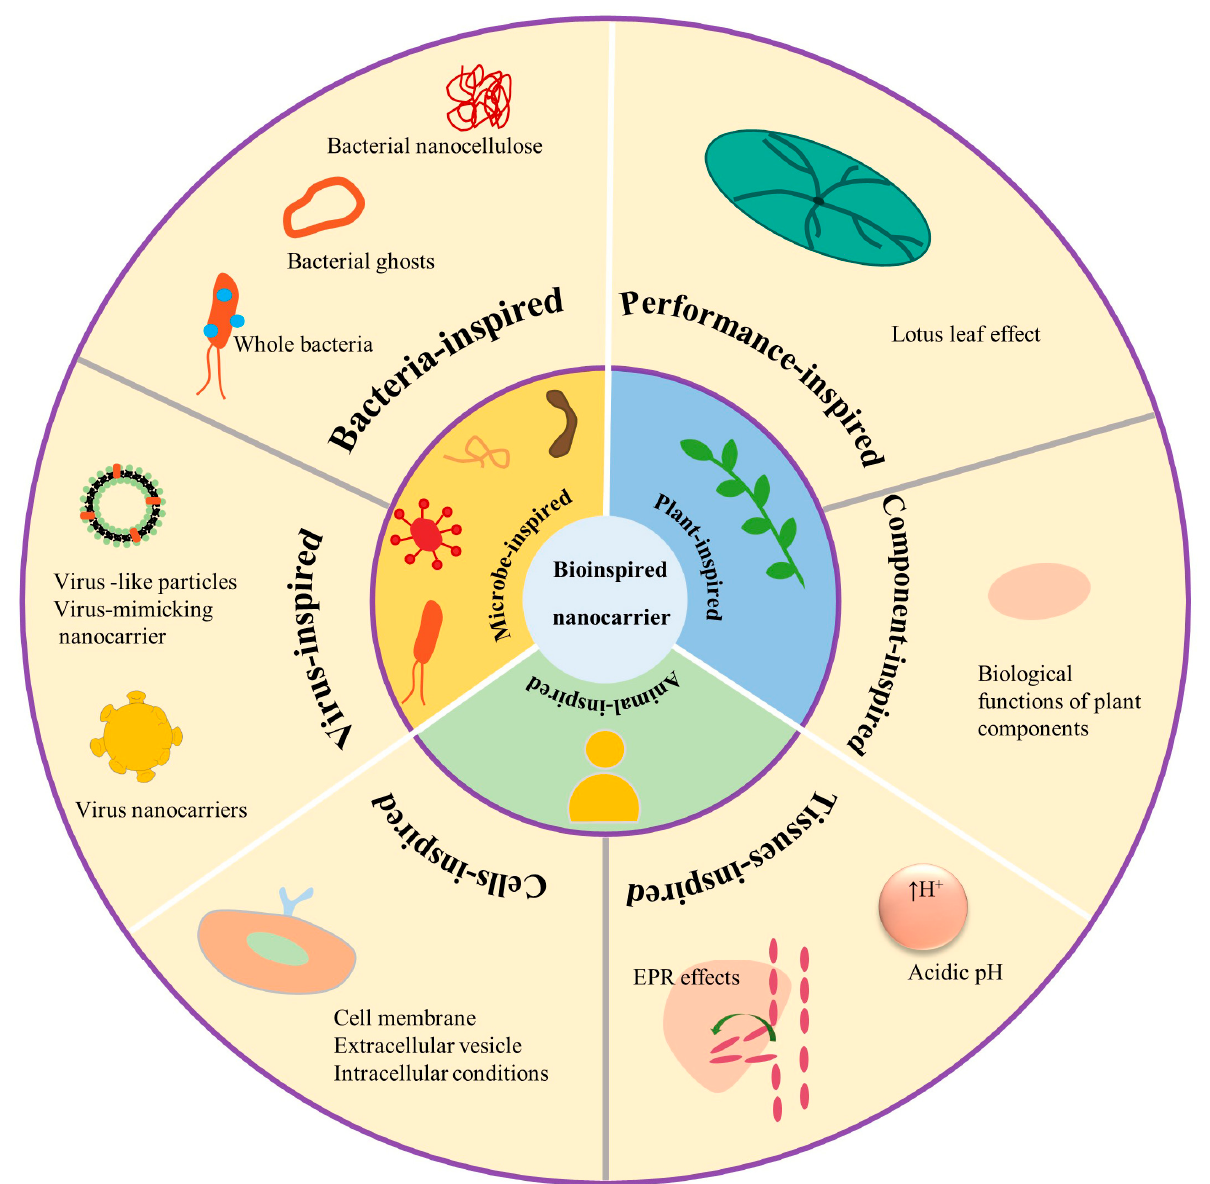
Figure 1. Schematic of a bioinspired carrier developed by the source and formulation of representative life from three kingdoms including microbe, plant, and animal. Abbreviations: EPR, enhanced permeability and retention.